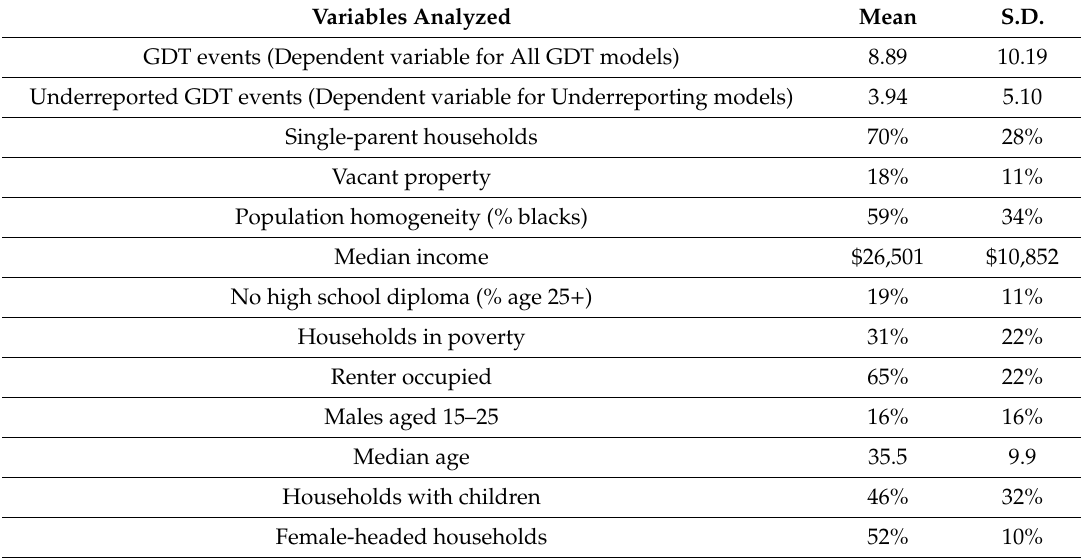
Table 4. Summary statistics for the dependent and independent variables in regression analysis (n = 82). Variables